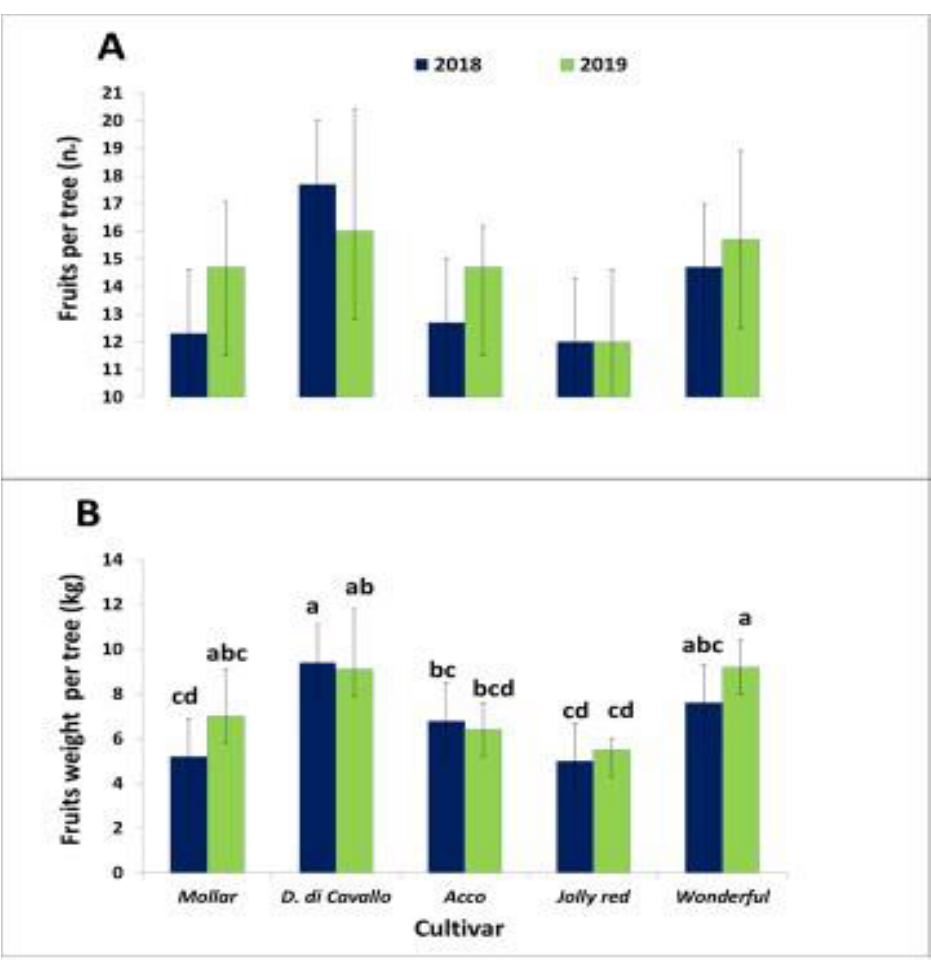
Figure 1. Number of fruits per tree ( A ) and fruit weight per tree ( B ) in different pomegranate cultivars. Average values ± std. dev. in 2018 and 2019 are shown. Different lower letters per year indicate significant differences at p < 0.05. Graph without letters means there were no significant differences between